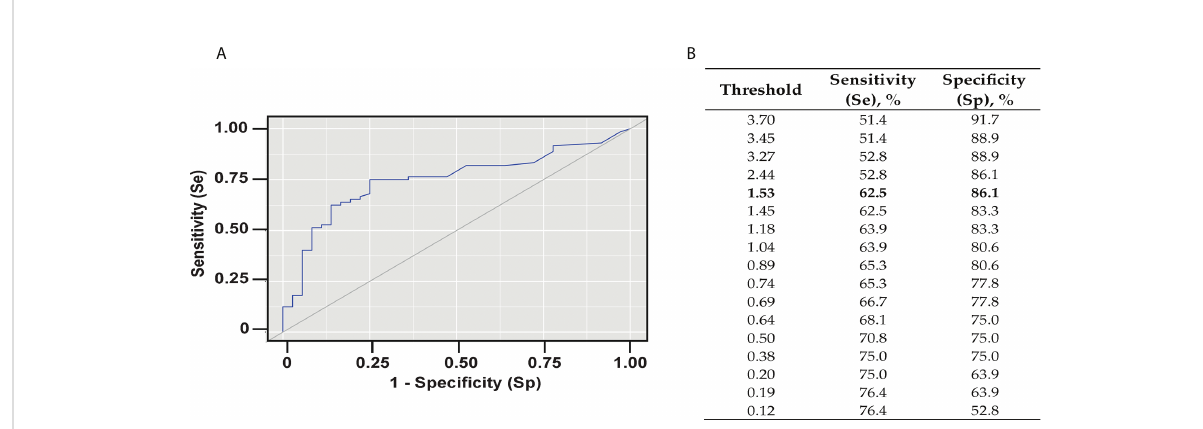
FIGURE 1 Diagnostic performance of Phadiatop ™ test. (A) ROC-curve characterizing the probability of a positive allergic anamnesis depending on the results of the Phadiatop ™ test. (B) Threshold values of the Phadiatop ™ test. Sensitivity (Se) is de fi ned as the proportion of positive tests among atopics. Speci fi city (Sp) is the percentage of negative tests among non-atopics.